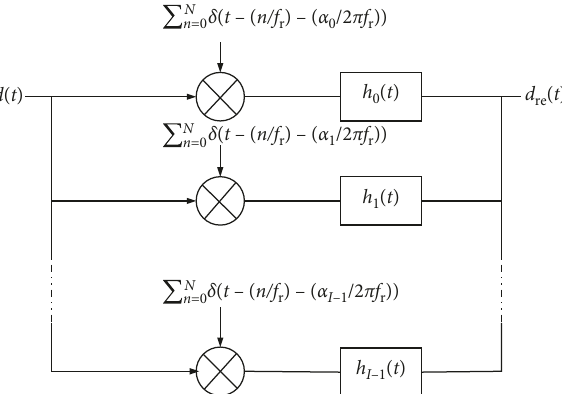
Figure 3: The schematic of periodically nonuniformly sampled signal reconstruction